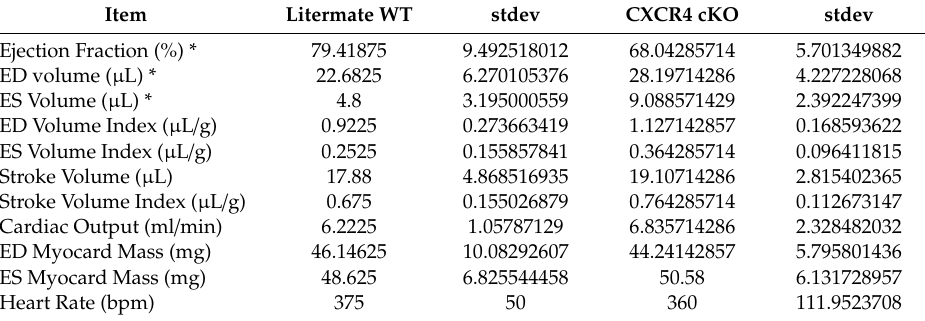
Table 1. MRI baseline analysis at 4 months of age. MRI experiments were performed using a General Electric Omega 9.4T vertical bore MRI system equipped, with a micro-imaging accessory and custom-built coils designed specifically for mice. MRI was performed at 4 months of age to analyze the baseline cardiac function. At 4 months of age, the CXCR4 cKO group demonstrated a significantly lower ejection fraction, as well as an increase in end-diastolic and end-systolic volumes suggesting mild functional defects. These data seem to suggest a mild cardiomyopathy present in the CXCR4 cKO. Abbreviations: EF, ejection fraction; EDV, end-diastolic volume; ESV, end-systolic volume; HR, heart rate.